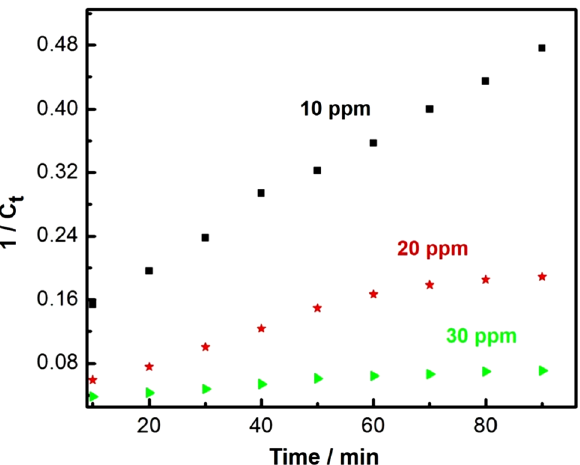
Figure 11. Pseudo second order kinetics of chloramine-T degradation (10 mg of nanocomposite, 50 ml chloramine-T solution, Temp = 25 °C and pH 7).